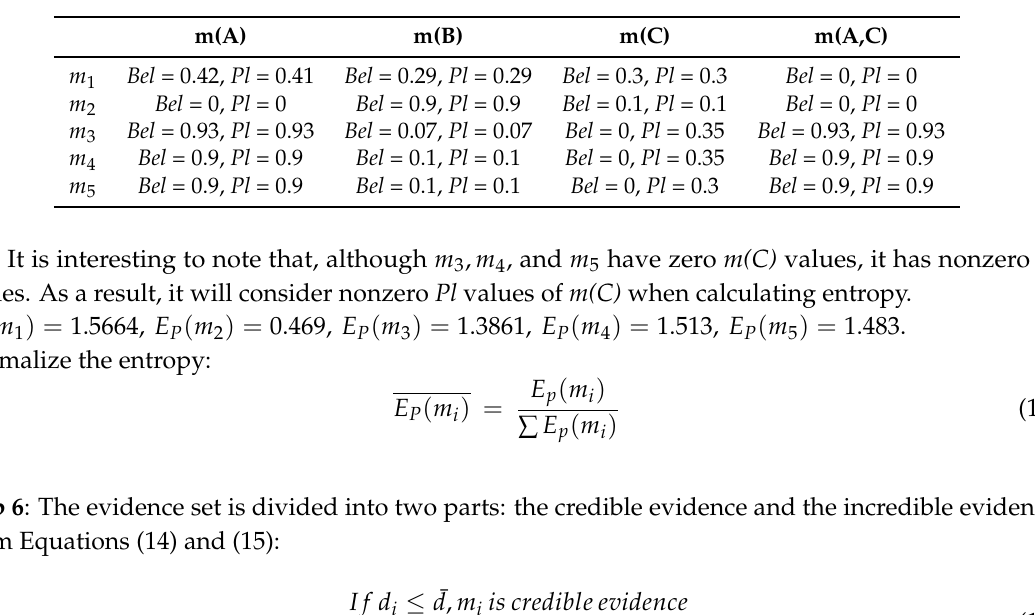
Table 3. Bel and Pl values for Example